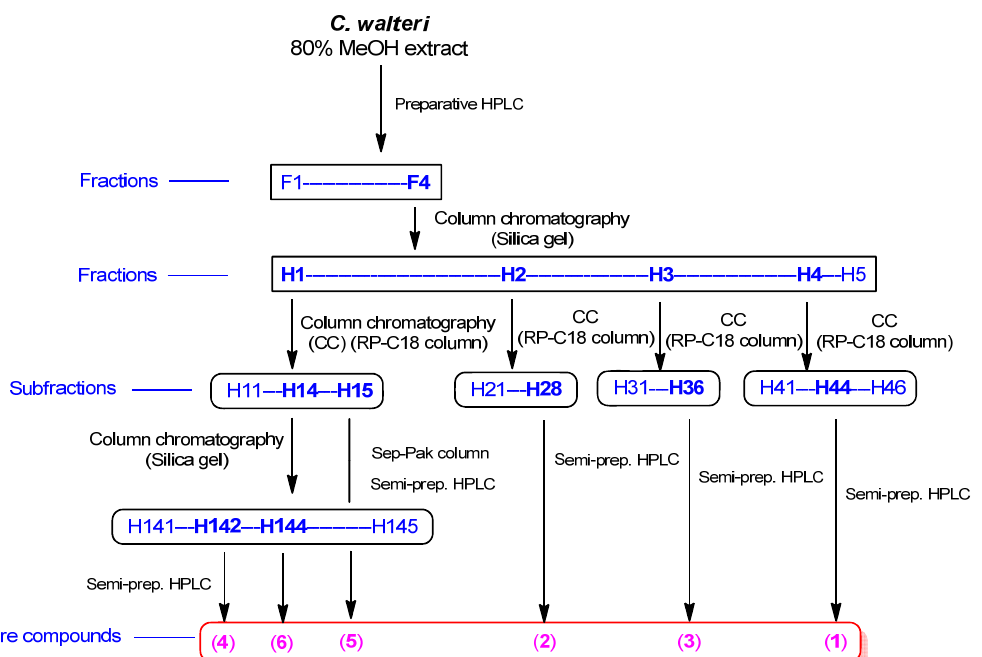
Figure 3. Separation scheme of compounds 1 – 6 .